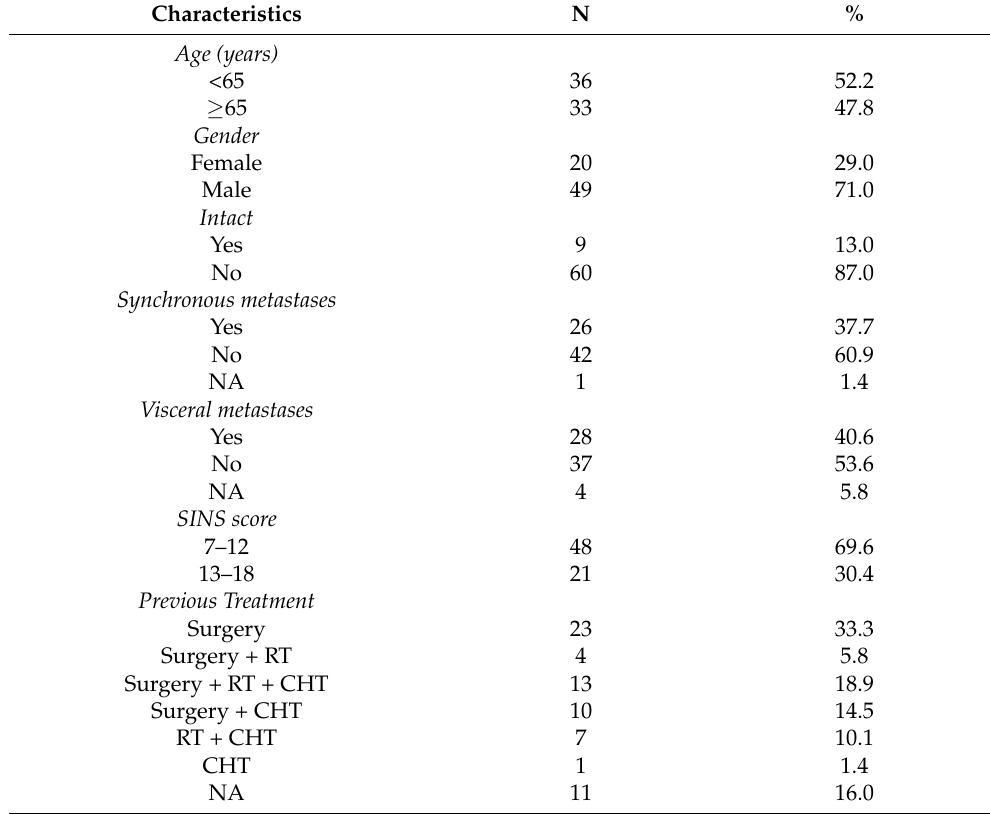
Table 1. Demographic and clinical data and sites of visceral metastases.